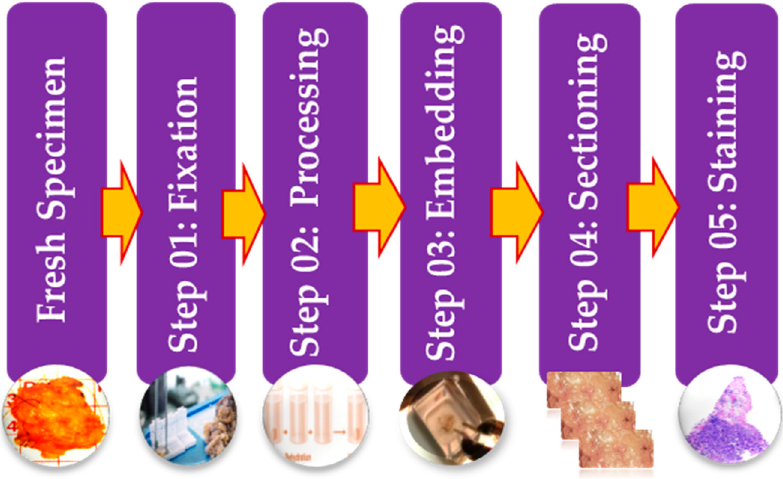
Figure 3. Illustrative figure showing the different preparation steps of histology slides.